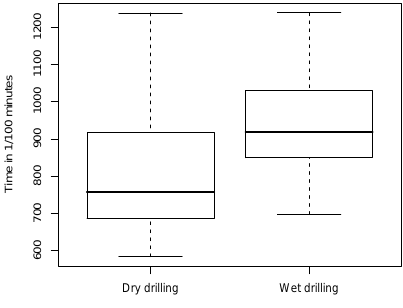
Figure 1. Box-plots of the drilling data samples. The estimated mean dry and wet drilling times are 805.53 and 943.81, re- spectively, giving an estimate for the mean difference µ w µ d equal to 138 . 3 . − This strongly indicates that both samples differ from each other. To find out whether this difference is statistically significant let us further test hypothesis (1.1) for the equality of sample means. This can be done either using the two– sample t -test, or by the empirical log-likelihood ratio statistic (3.5). Both tests reject the null hypothesis with a p -value of < 0 . 0001